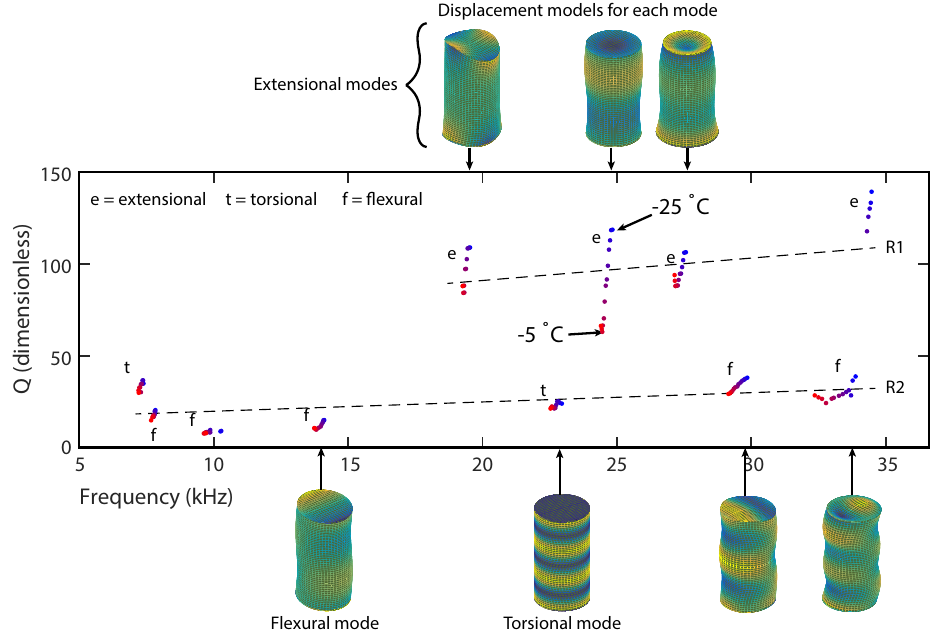
Figure 6. Quality factor Q as a function of temperature and frequency for 11 resonant peaks. Each resonance mode is identified as flexural, extensional, or torsional. R1 and R2 are linear regressions for the extensional modes and the flexural/torsional modes respectively, which show a general trend of increasing Q with f